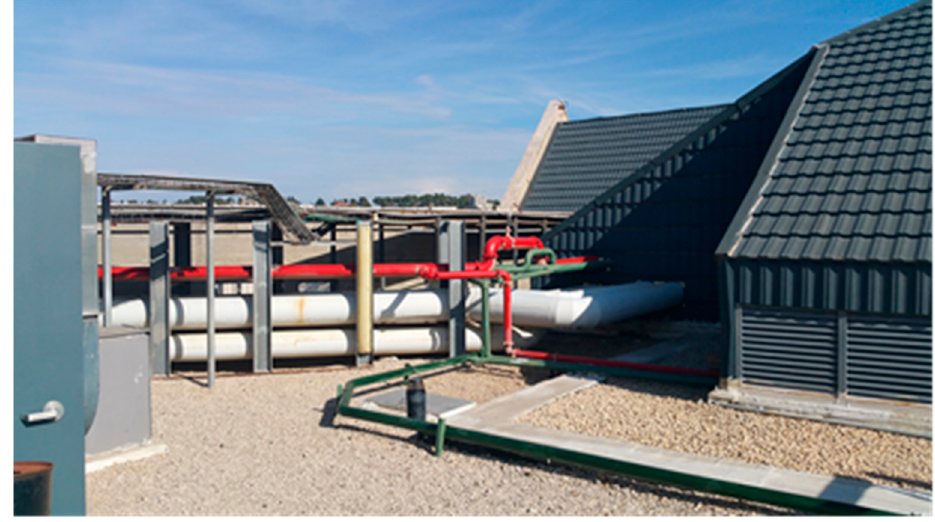
Figure 11. Roofing and installations (Maintenance Indicator = 2.5).